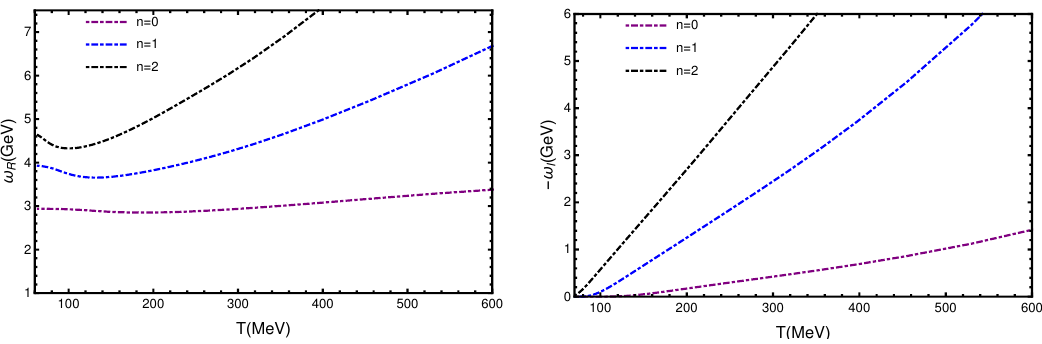
Figure 5 . Real and imaginary parts of the frequencies of charmonium quasinormal modes as function of the temperature. The real part of the frequencies is shown on the left side, and the imaginary part on the right